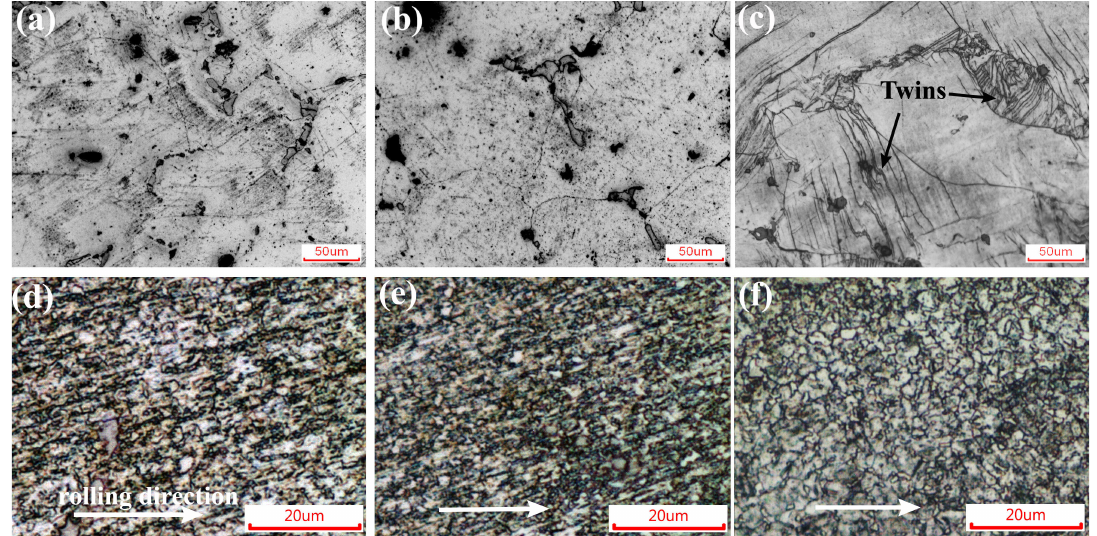
Figure 3. Optical micrographs of the AZ91 alloy in different processing state: ( a ) SHT + rolling at room temperature, ( b ) SHT + rolling at 100 °C, ( c ) SHT + rolling at 150 °C, ( d ) SHT + ECAP 8p + rolling at room temperature, ( e ) SHT + ECAP 8p + rolling at 100 °C, ( f ) SHT + ECAP 8p + rolling at 150 °C.